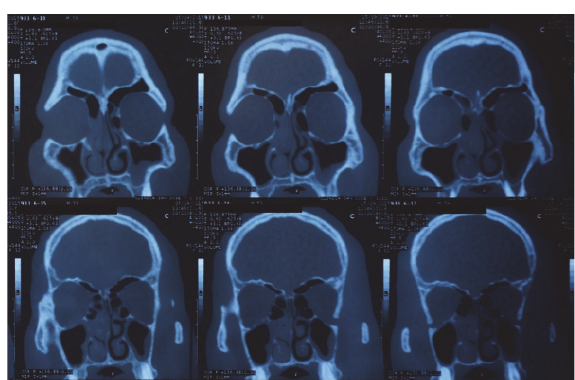
Figure 2: Coronal CT demonstrating mucosal thickening in the right nasal turbinates and left maxillary sinus.